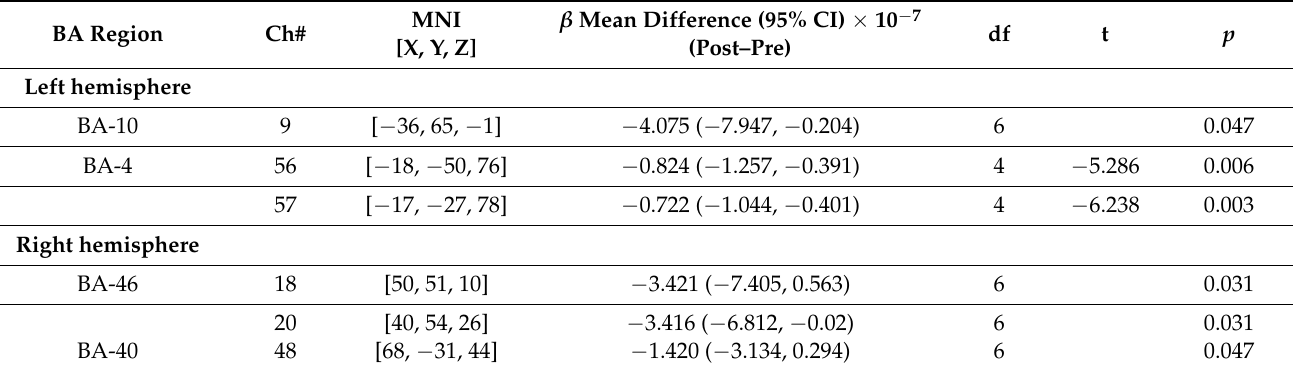
Figure 4. Contrast between real and sham mPES. ( A ) The number of involuntary swallows induced by real and sham mPES. n = 20, **** p < 0.0001, Wilcoxon test. ( B ) Real mPES versus sham mPES activation for HbO. The colored regions denote cortical areas that were significantly activated (paired t -test, p < 0.05, FDR corrected). Statistical results refer to Table 1. ( C ) Cortical activity (beta coefficient) correlates with behavior (involuntary swallow frequency). Partial Pearson’s correlation with age and gender as covariates, n = 20, uncorrected. mPES modified pharyngeal electrical stimulation. Table 2. Post-versus pre-mPES-related cortical activation after prolonged Table 1. Real versus sham mPES-related cortical activation during immediate mPES.